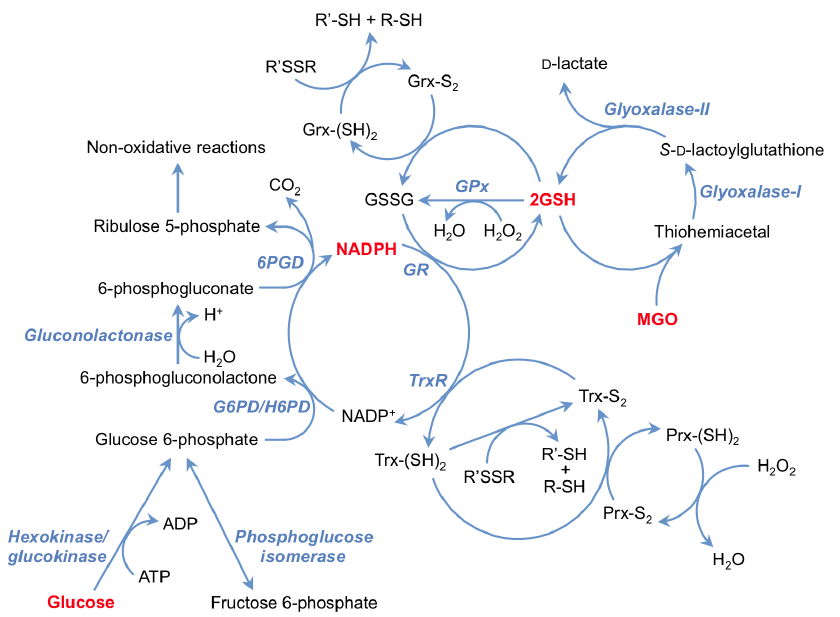
Figure 1. Interconnection of the oxidative pentose phosphate pathway with antioxidant enzymes and the glyoxalase system. Abbreviations: glutathione, GSH; glutathione peroxidase, GPx; thioredoxin, Trx; thioredoxin reductase, TrxR; peroxiredoxin, Prx; glutaredoxin, Grx. Modified from [45].